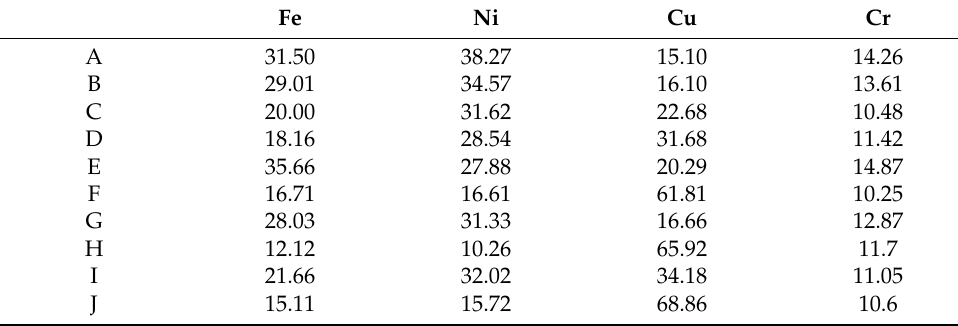
Figure 9. SEM micrographs in the weld zones: ( a – c ) joint 1 and ( d – f ) joint 2. Table 4. Chemical compositions of marked phases in Figure 9 (at.%).